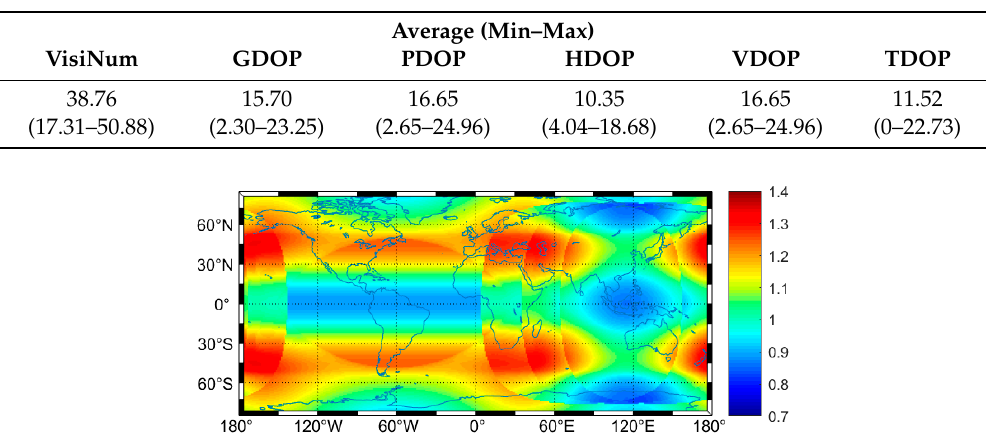
Figure 9. The ratio of positioning precision between the longitude component and the component latitude for BDS-3.